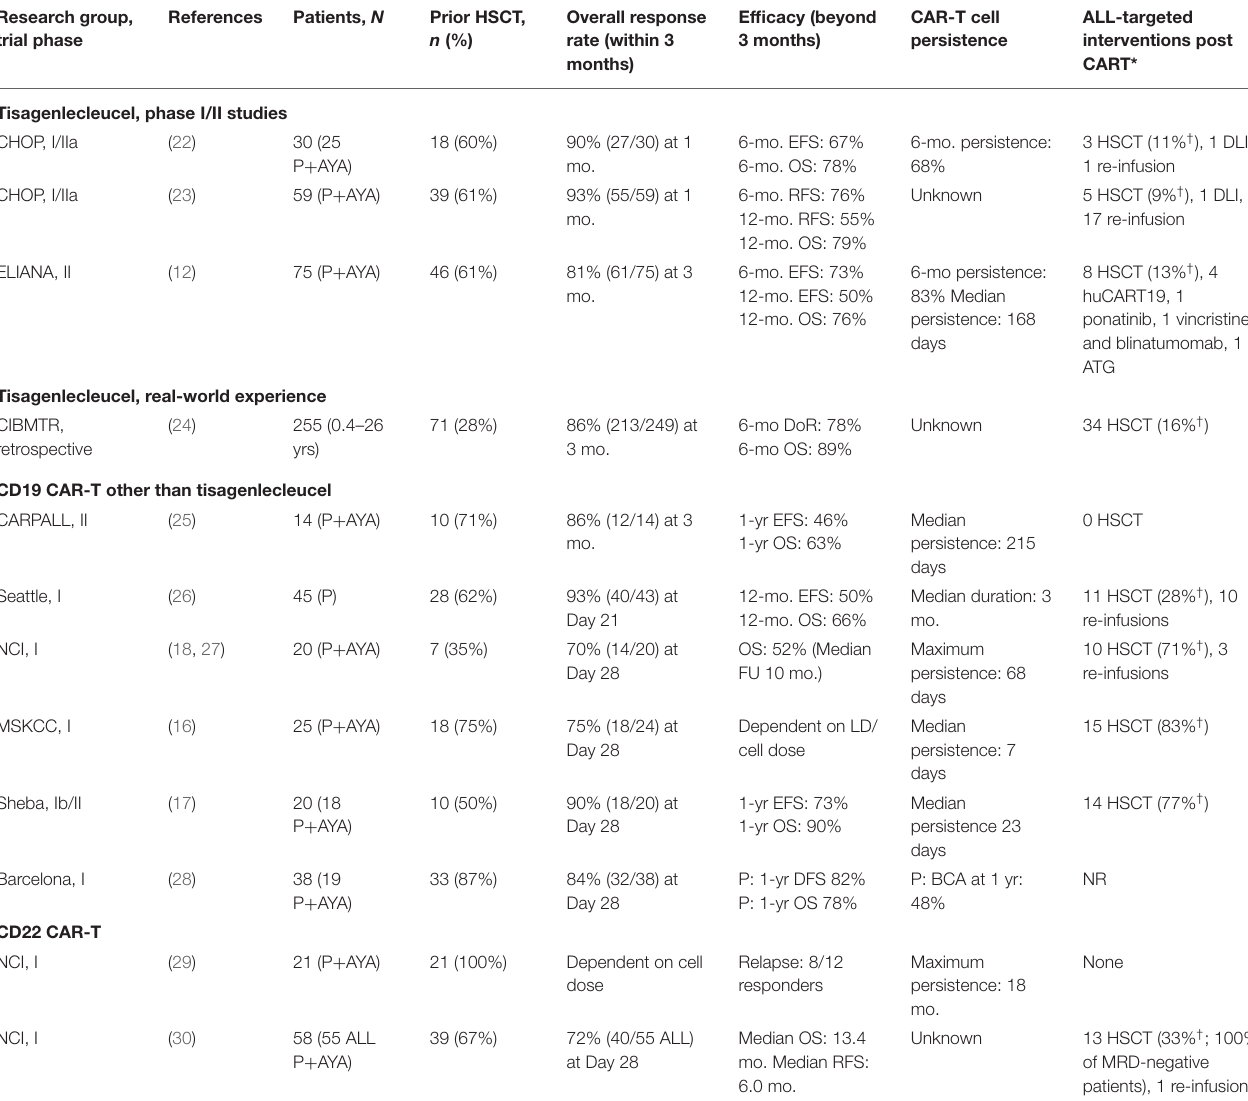
TABLE 1 | Overview of the main clinical studies investigating CD19- or CD22-targeted CAR-T in paediatric patients and AYA with